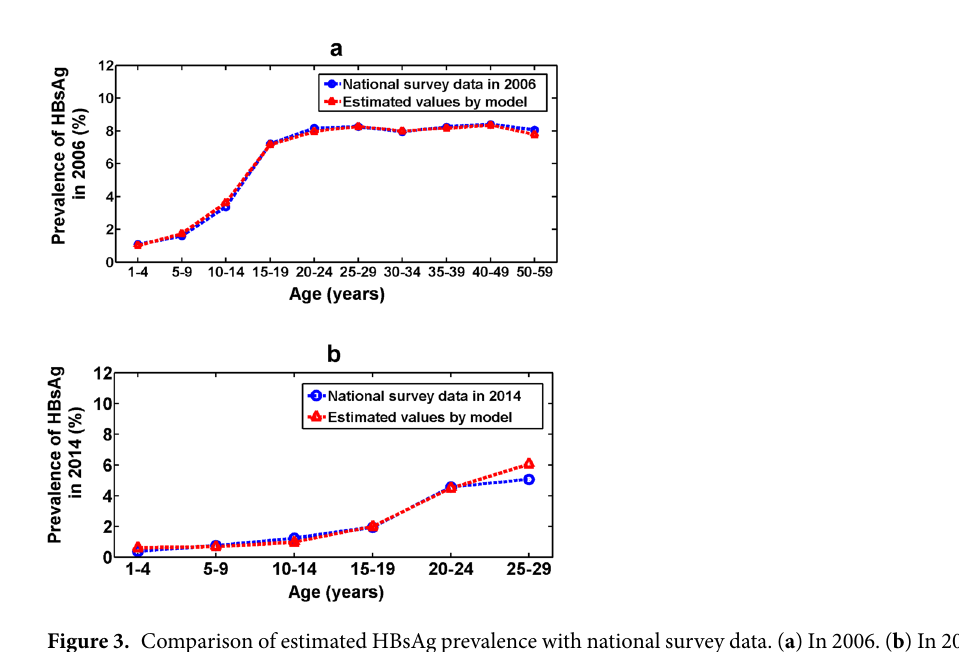
Figure 3. Comparison of estimated HBsAg prevalence with national survey data. ( a ) In 2006. ( b ) In